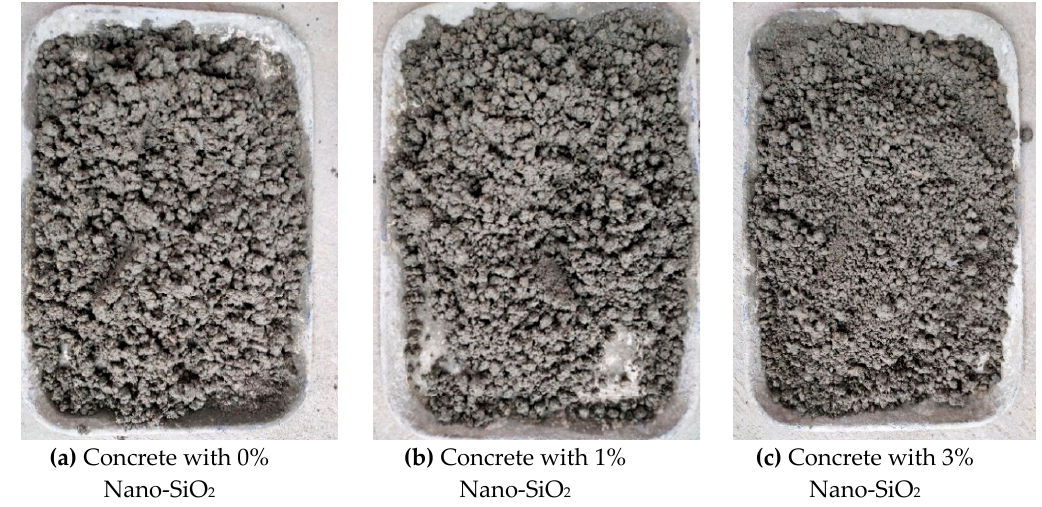
Figure 3. Nano-SiO 2 powder and solution.